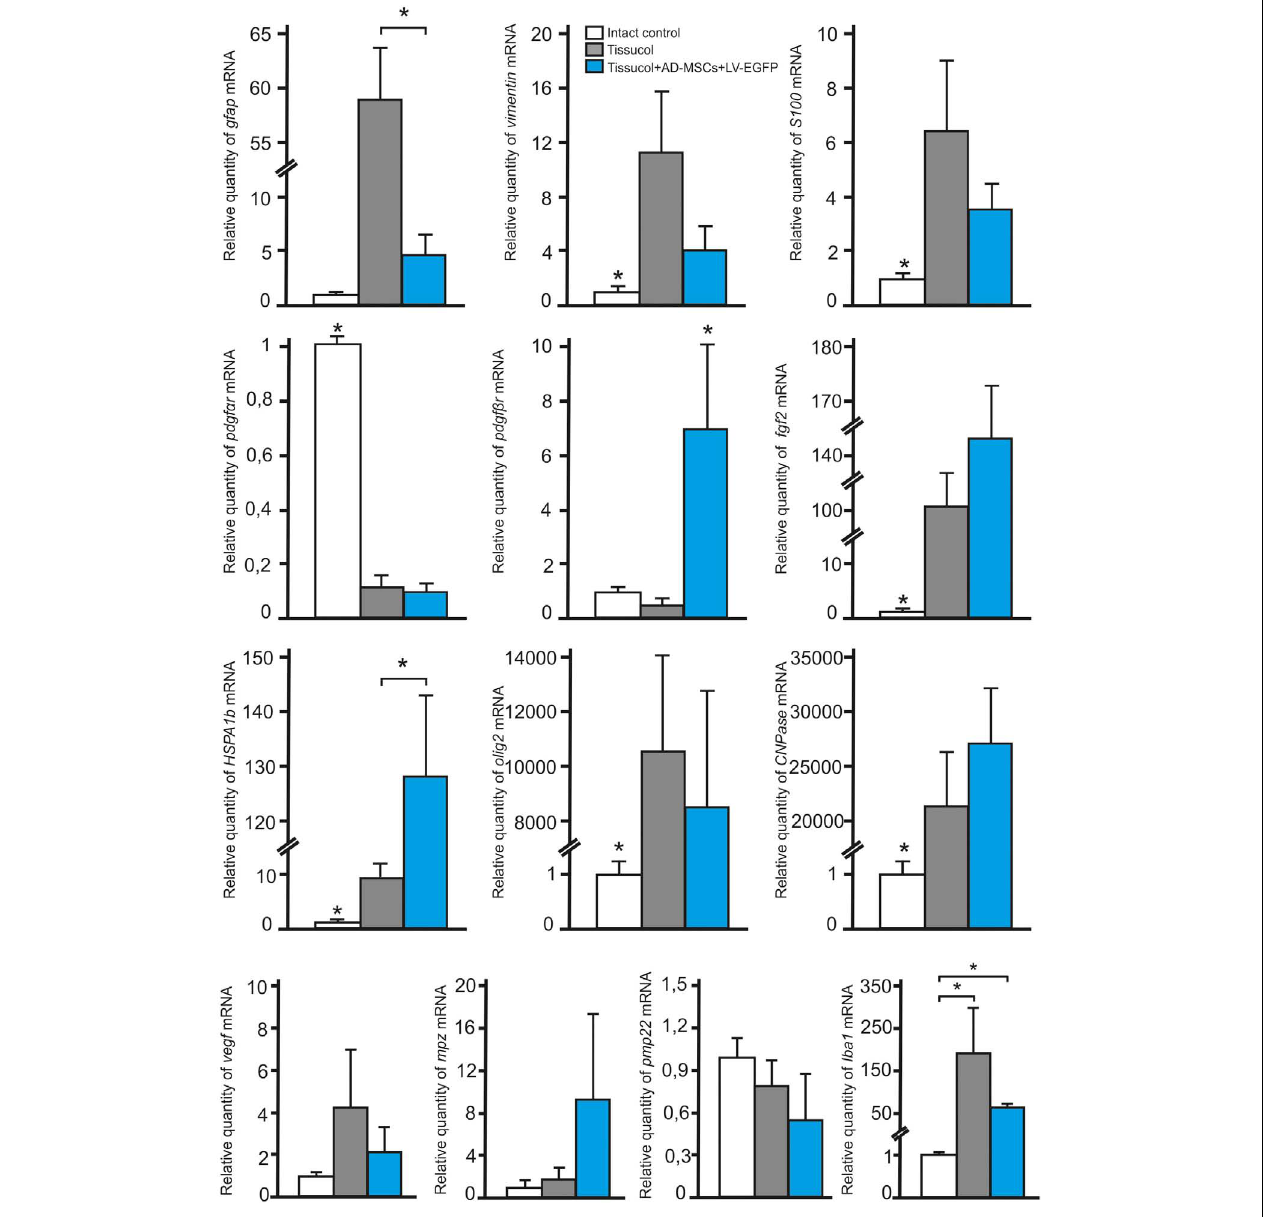
FIGURE 5 | Analysis of changes in mRNAs expression in the area of SCI. GFAP, VIMENTIN, S100, PDGF α R, PDGF β R, FGF2, HSPA1b, OLIG2, CNPase, IBA1, MPZ, PMP22, and VEGF mRNA expression in intact spinal cord (write column) or in 60 days after Tissucol (gray column) and Tissucol+AD-MSCs+LV-EGFP (blue column) application. The mRNA expression levels in intact spinal cord was considered as 100%. ∗ P < 0.05, one-way ANOVA followed by a Tukey’s post hoc